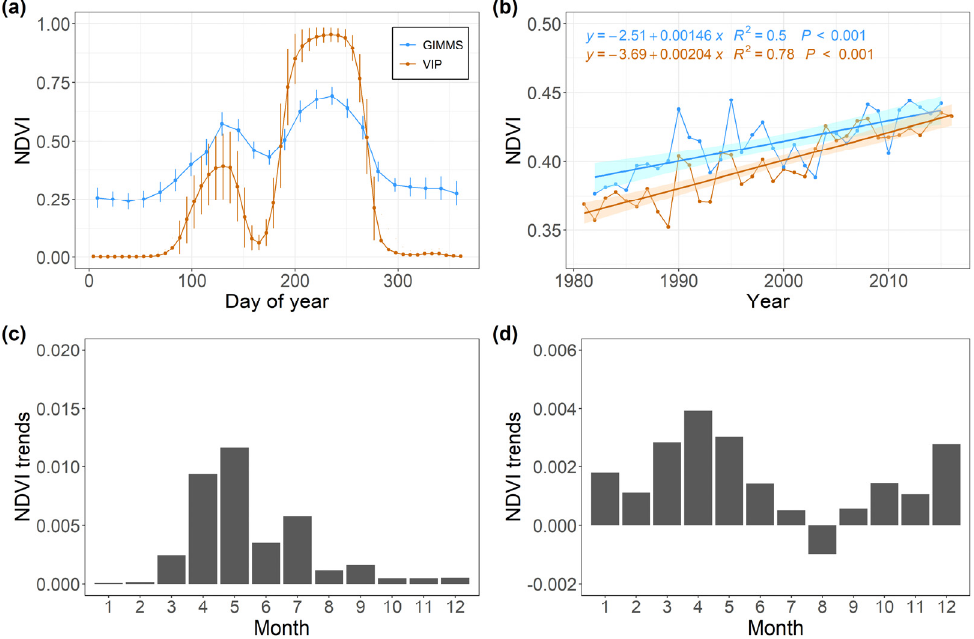
Figure 2. Seasonal profiles and variation trends of the spatial average NDVI over the study region. ( a ) Seasonal profiles of the multi-year-space average NDVI from VIP (blue) and GIMMS (brown); ( b ) interannual changes of the spatial and annual average NDVI from VIP (blue) and GIMMS (brown); ( c ) monthly variation trend of NDVI for VIP; ( d ) monthly variation trend of NDVI for GIMMS. The error bar in ( a ) denotes the standard deviation.